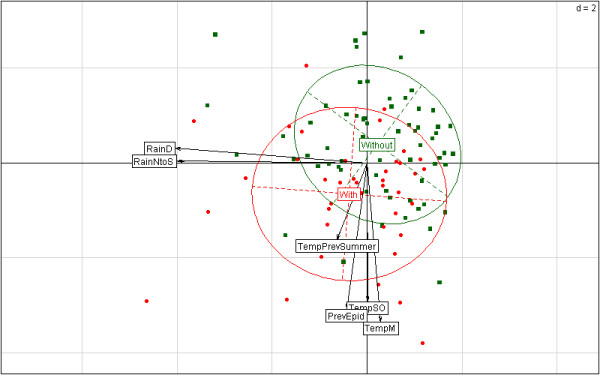
Multivariate analysis to illustrate the interrelationships between the favourable factors. Abbreviations for variables: RainD, rainfall during the December month of the previous year; RainNtoS, rainfall from November to September; TempPrevSummer, mean temperature of the summer of the previous year; TempM, mean temperature of March; TempSO mean temperature of September-October; PrevEpid, presence of an epidemic during the previous year. On the one hand, the horizontal axis, accounting for 27.2% of the total variance, gives a precipitation gradient. Hence, the more a year is situated on the left, the more rainy it is globally. On the other hand, the vertical axis, accounting for 26.4% of the total variance, summarizes the factors due to temperature and to the presence of an epidemic the previous year. The binary epidemic factor is used as a supplementary variable. Years with and without epidemics are symbolized by red circles and green squared symbols, respectively. Thus epidemics were more frequently observed in years that were warmer and rainier (the convenient months).